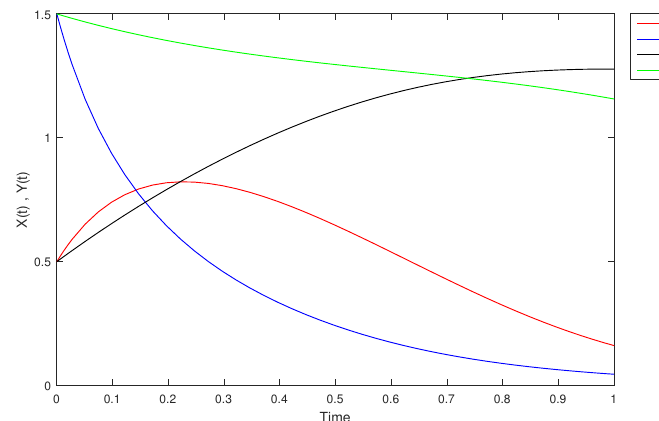
Figure 26. The solution of (13) at α = 0.0 for a short time period.